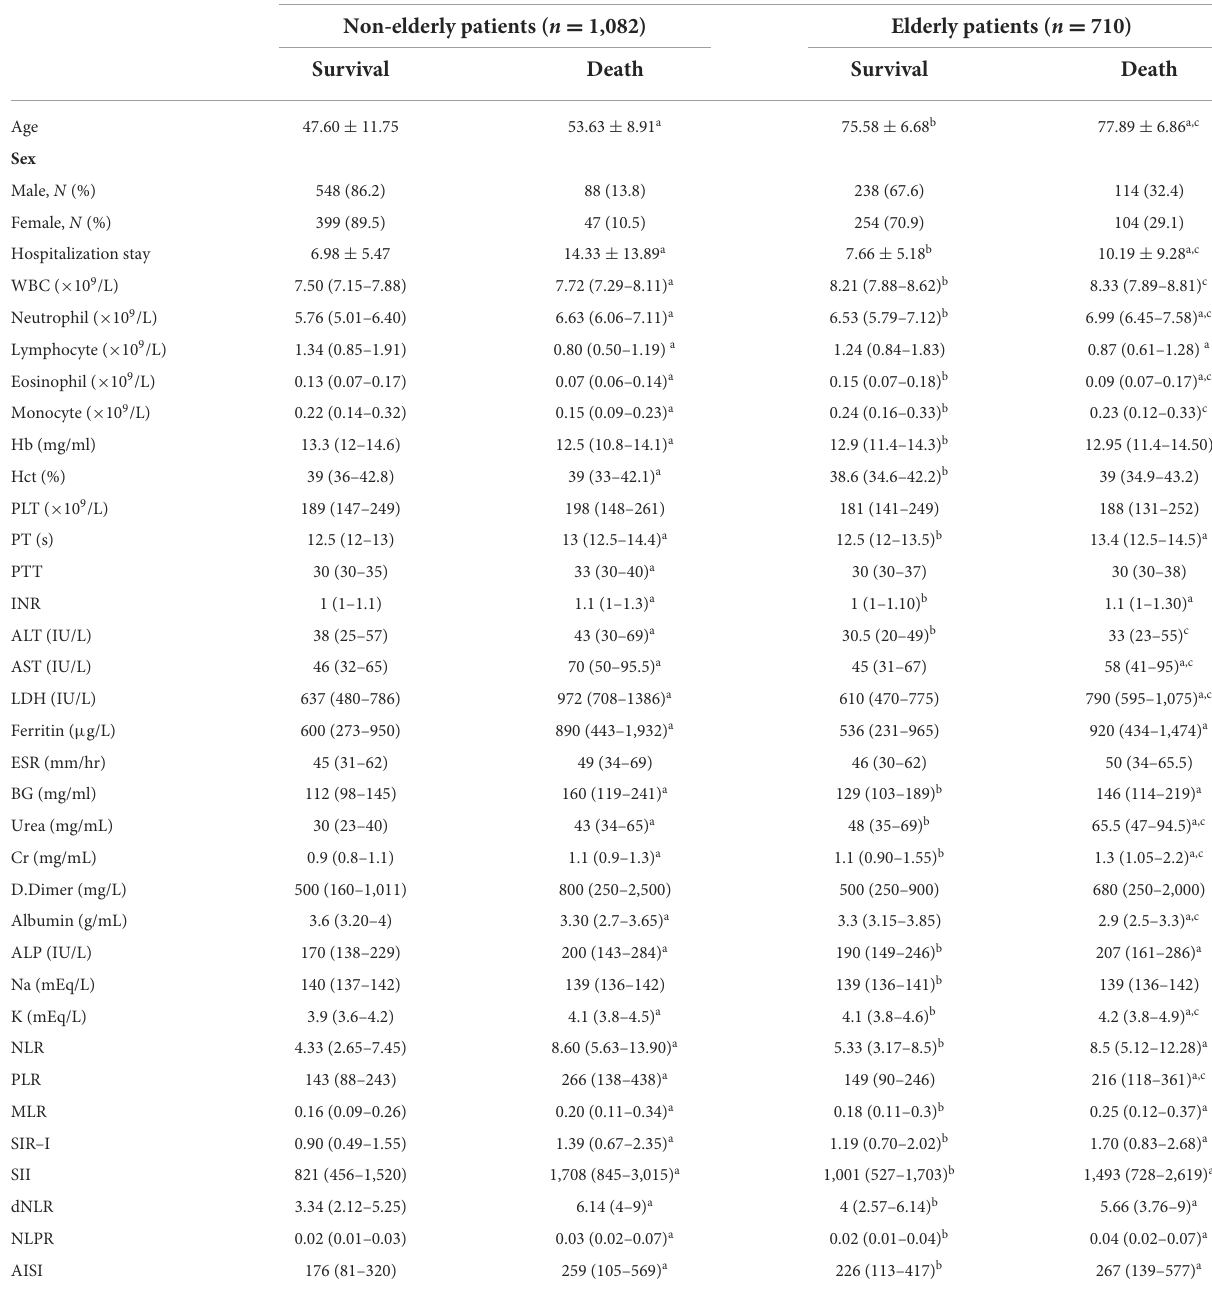
TABLE 2 Demographic, hematological, and blood cell count-derived inflammation indexes of non-elderly and elderly COVID-19 in survivor and non-survivor